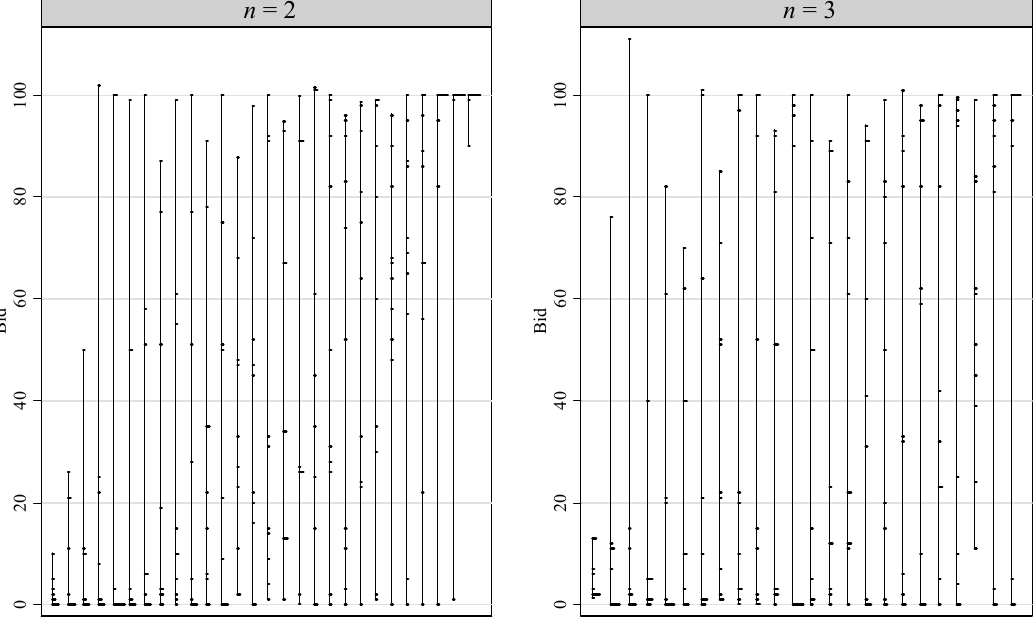
Note : Vertical lines show the spread of the bids of each individual, small horizontal lines depict the frequency of the corresponding bid (bids are rounded to